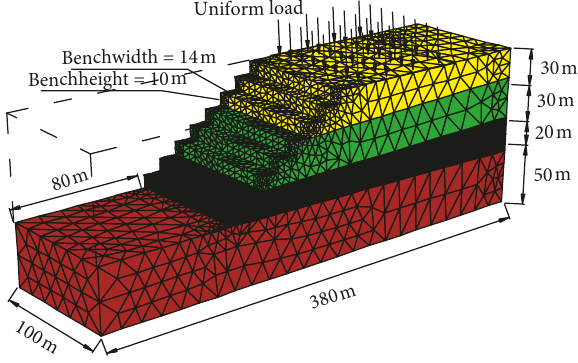
Figure 2: Details of modeled geometry.